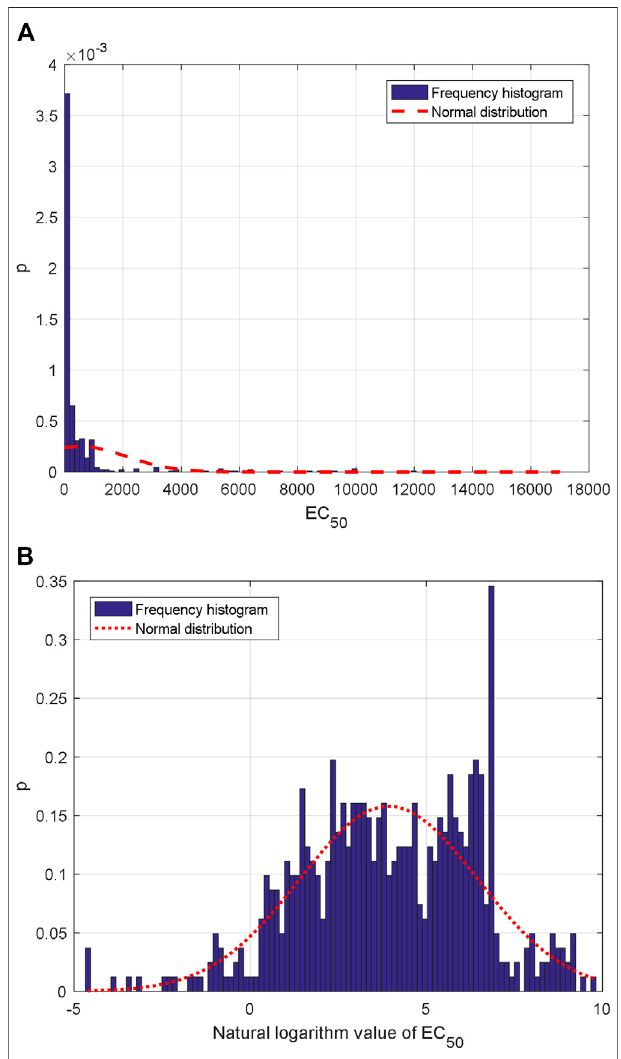
FIGURE 2 | Statistical histogram: frequency histogram of (A) AHTPA- EC 50 and (B) natural logarithm of AHTPA-EC 50